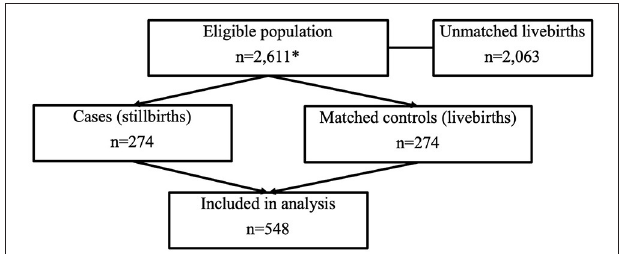
FIGURE 1 | STROBE (16) flow diagram for case-control study. *Within the eligible population box, this details the total number of live and stillbirths throughout the time match